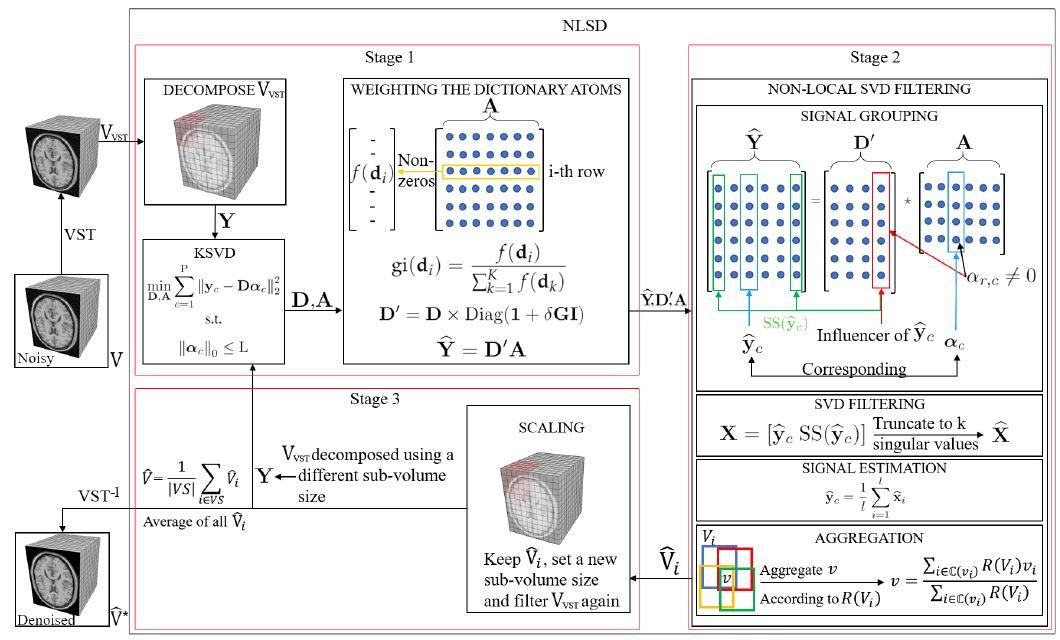
Figure 2. Block diagram illustrating the three steps of the proposed